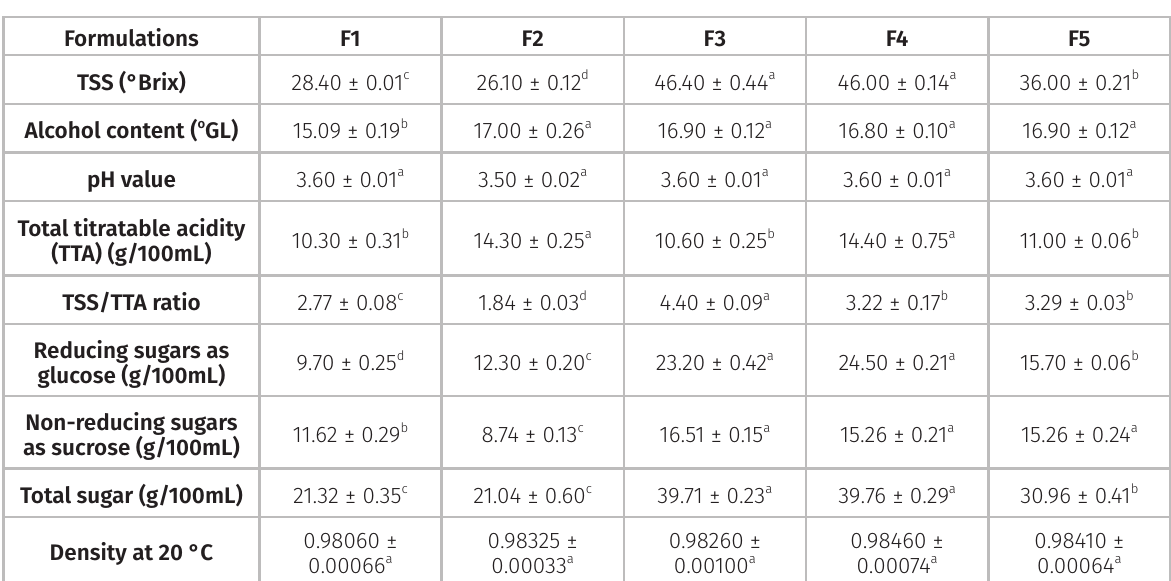
Table II. Physicochemical characterization of the wild passion fruit ( Passiflora cincinnata Mast.) liqueur